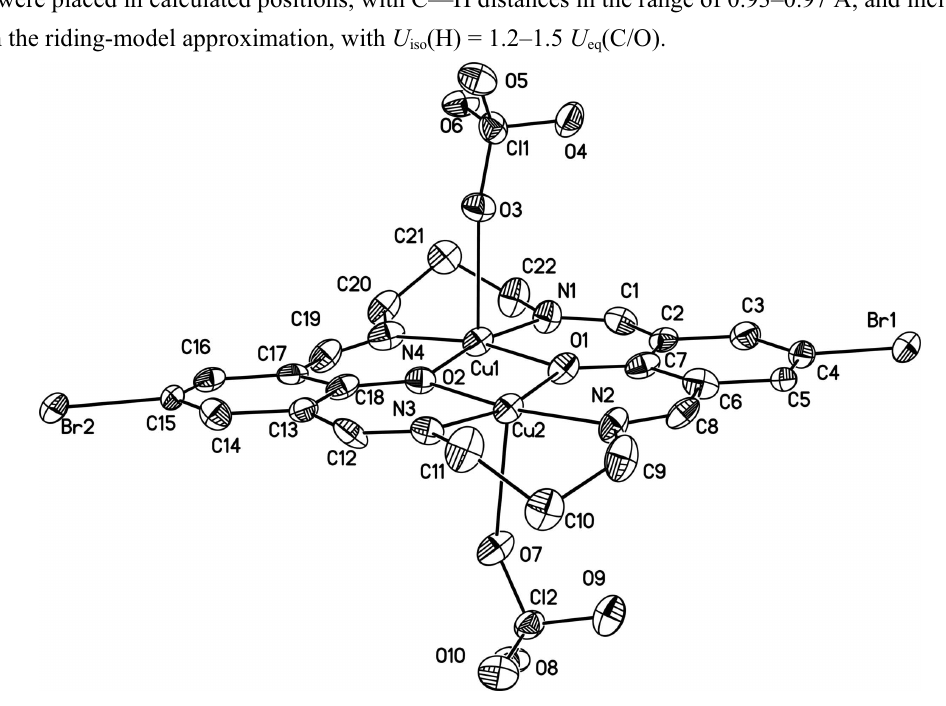
A view of the stucture of the title complex, showing the labeling of the non-H atoms and 30% probability ellipsoids; H atoms have been omitted for